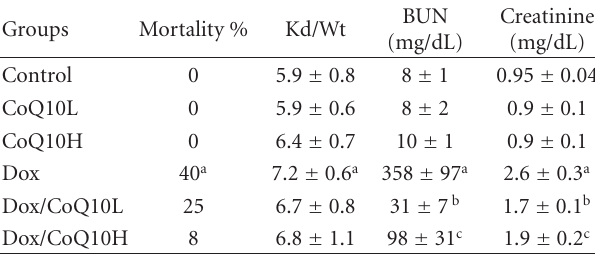
Table 1: E ff ect of coenzyme Q10 (CoQ10) on percent of animal mortality, kidney/body weight ratio, blood urea nitrogen (BUN), and creatinine in doxorubicin- (Dox-) induced nephrotoxicity in rats.